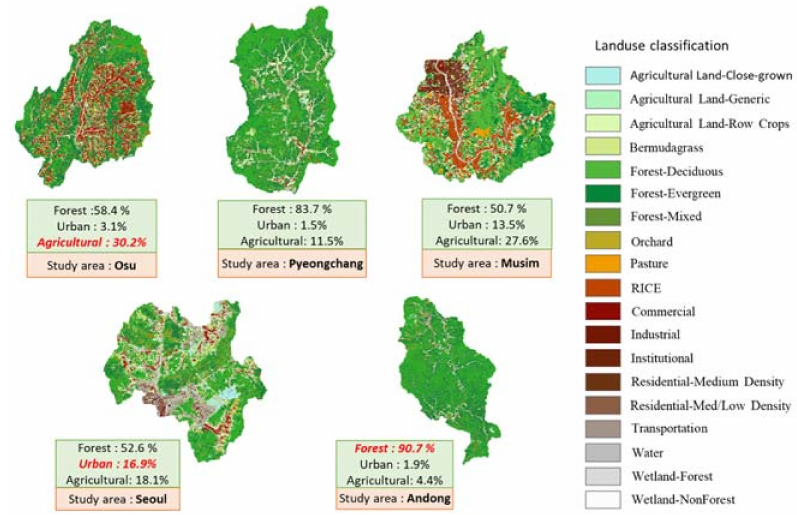
Figure 2. Land use of the five study watersheds (Seoul, Musim, Osu, Pyeongchang,